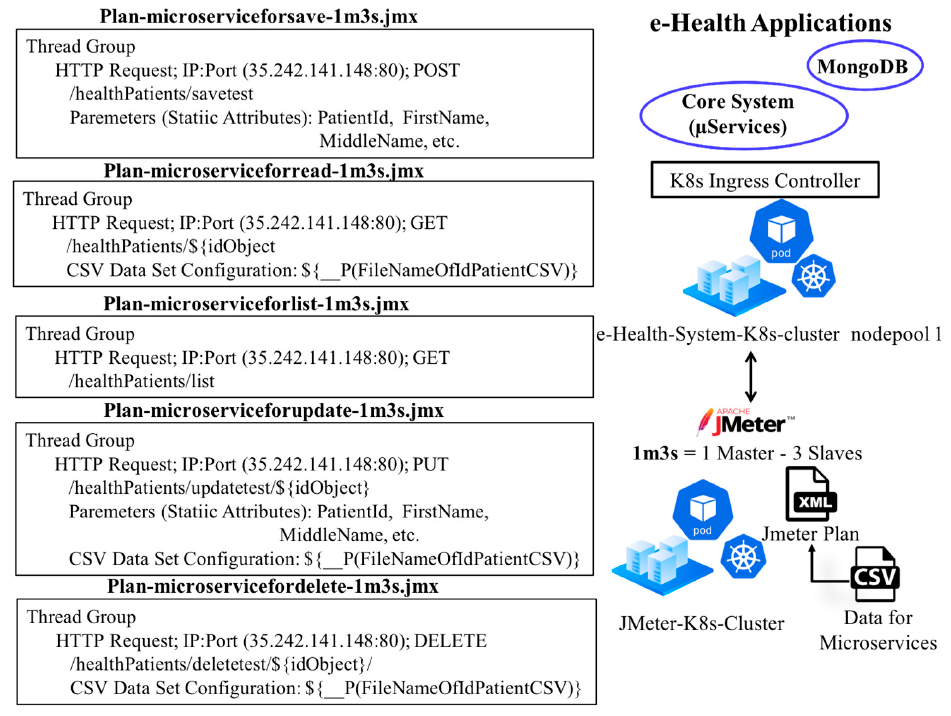
Figure 14. The simulation environment for microservice testing.